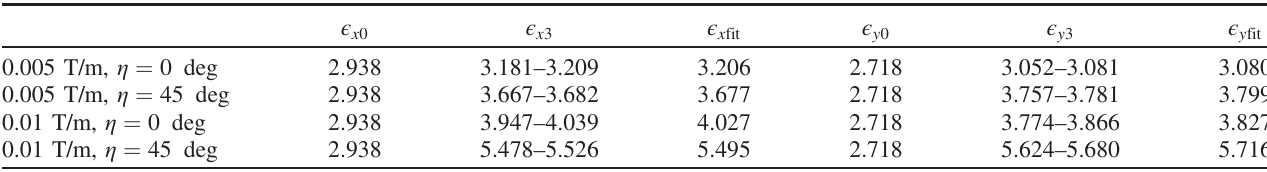
TABLE I. Comparing the initial emittance on the cathode ϵ 0 , the actual emittance at the screen ϵ 3 , and the measured emittance with solenoid scan ϵ under different strength and rotation angle of the solenoid quadrupole. The unit of the emittances is mm mrad. fit